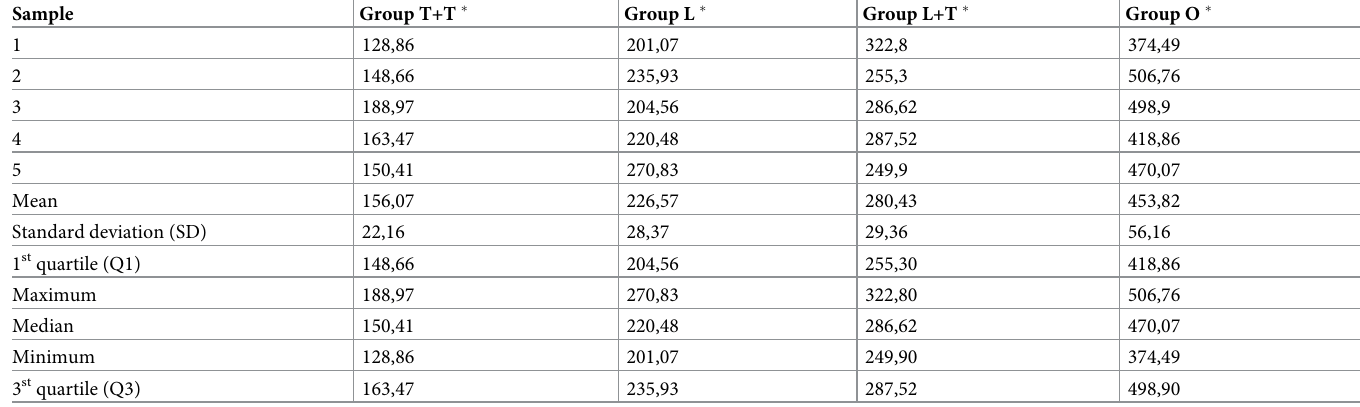
Table 2. Stiffness values (N/mm) in each sample of the four groups (T+T, L, L+T, O), and the values behind the mean, standard deviation (SD), 1 st quartile (Q1), maximum, median, minimum, and 3 rd quartile (Q3). Sample